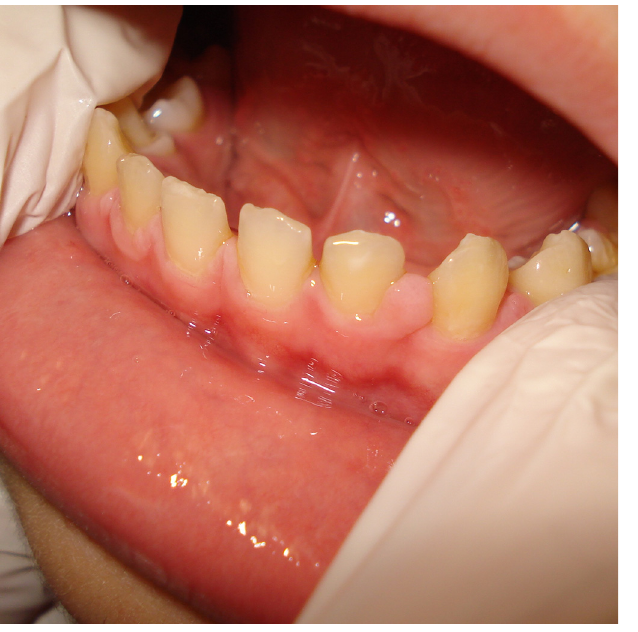
Fig. 1. Gingival fi bromas of the mandible. Fig. 2. Hypomelanotic macula of the right